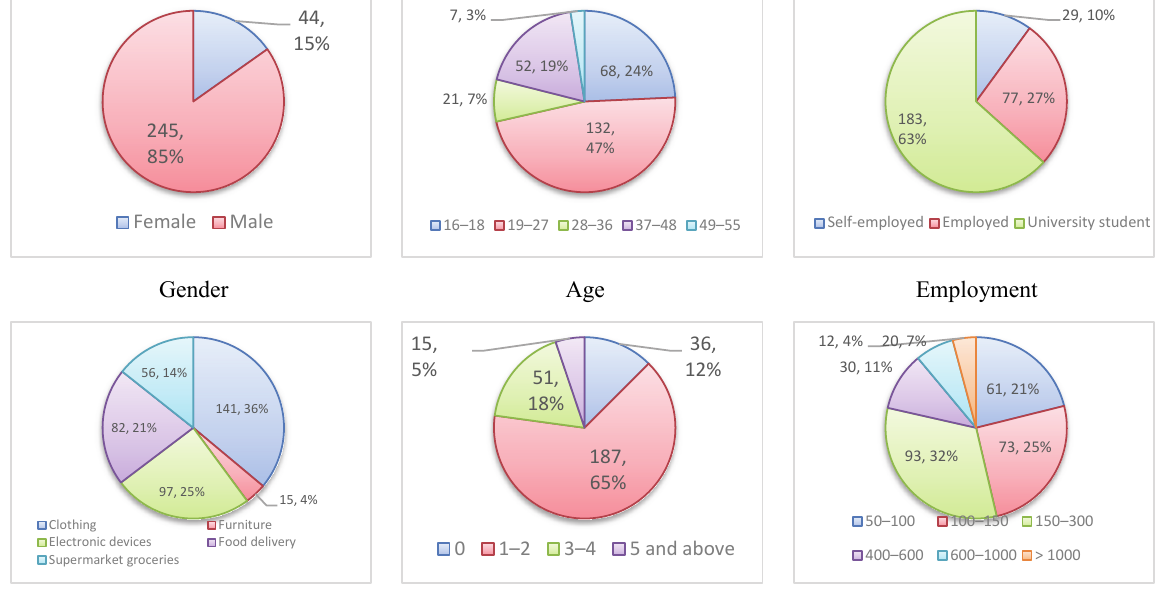
Fig. 2. Personal characteristics of the